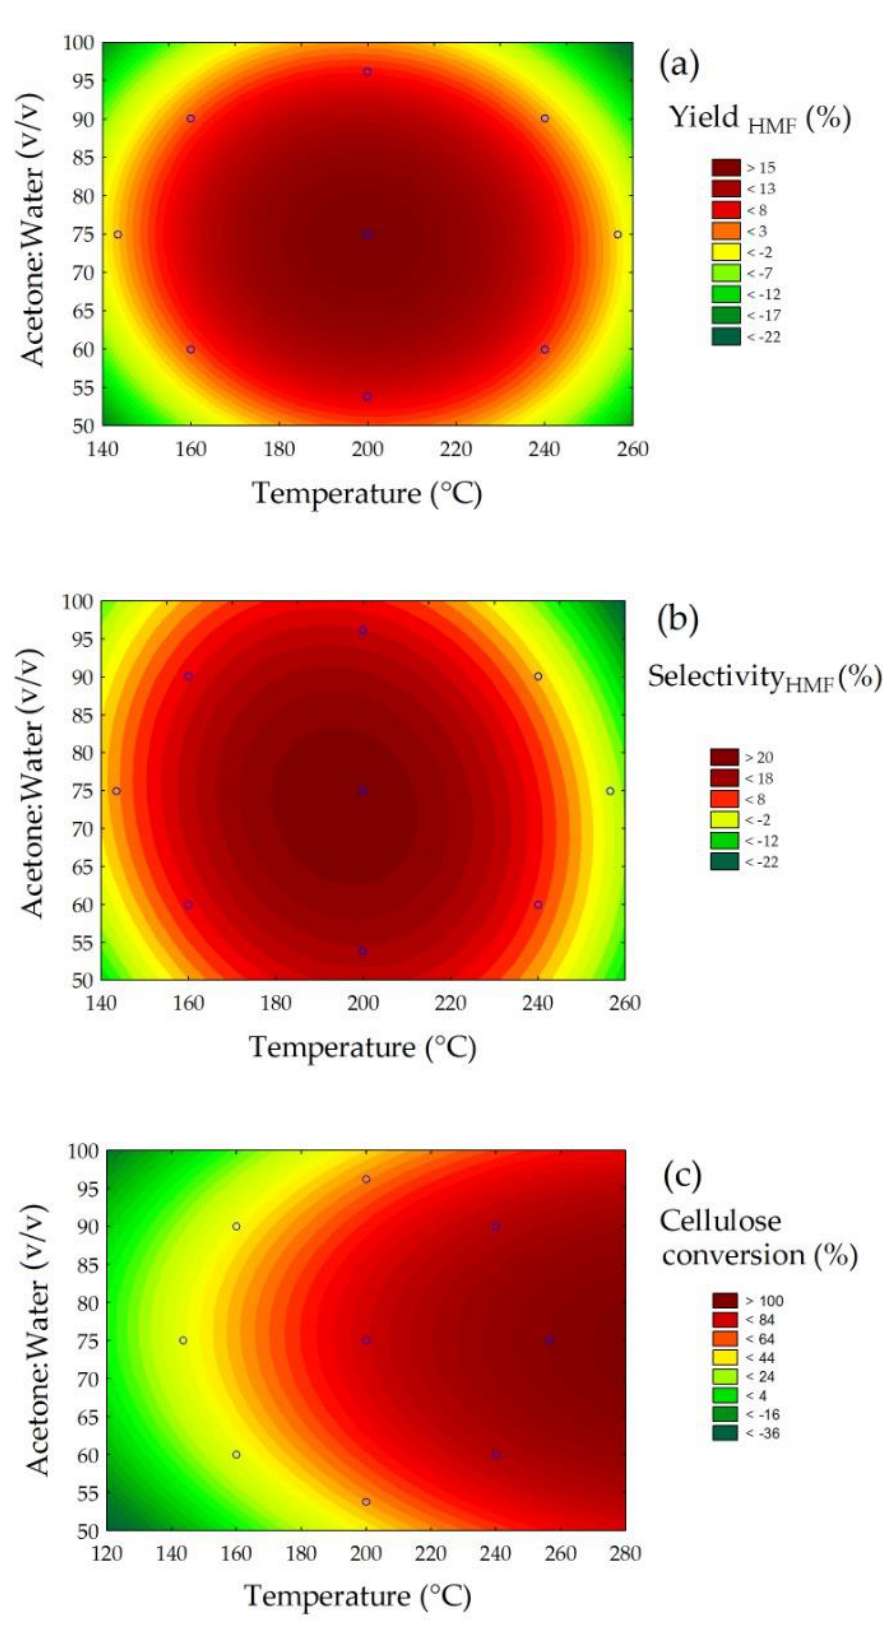
Figure 6. Contour plots of reaction temperature and acetone:water ratio ( v / v ) as a function of HMF yield ( a ), HMF selectivity ( b ) and cellulose conversion ( c ).